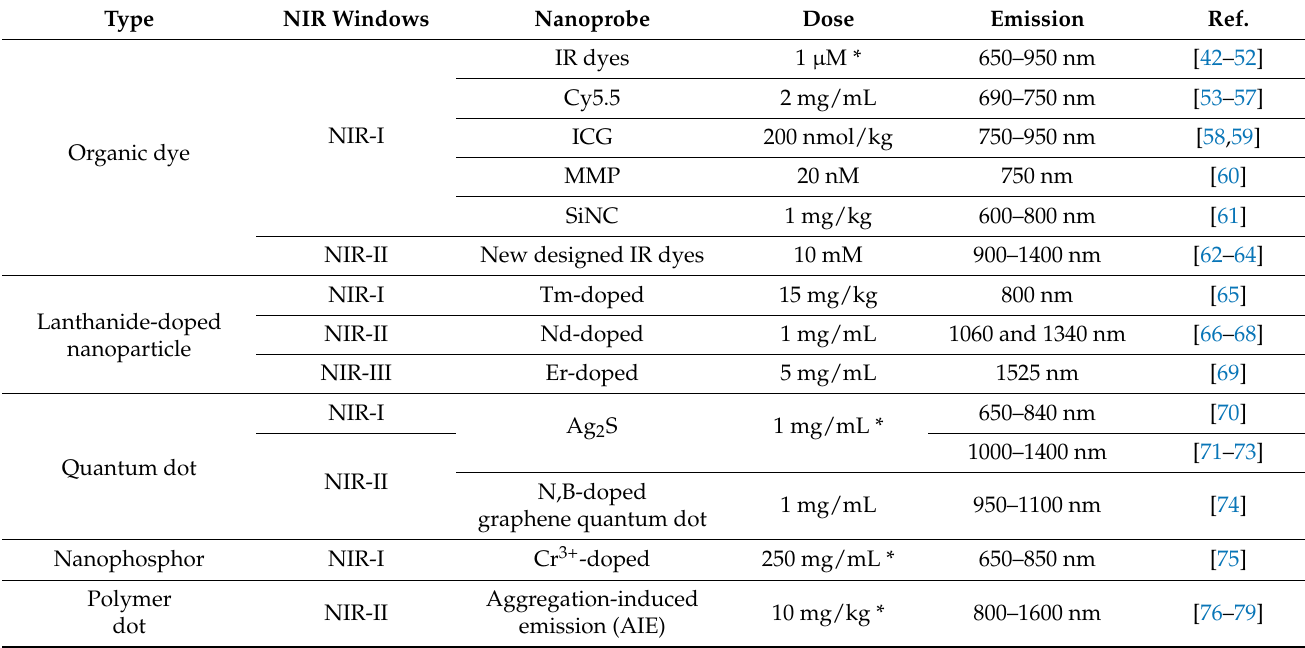
Table 1. The in vivo NIR imaging with different